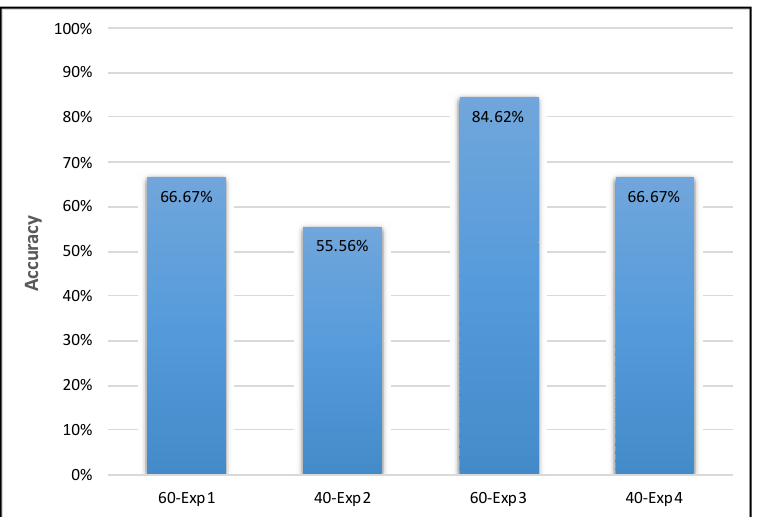
Figure 7. Comparison of the valence experiments’ results.